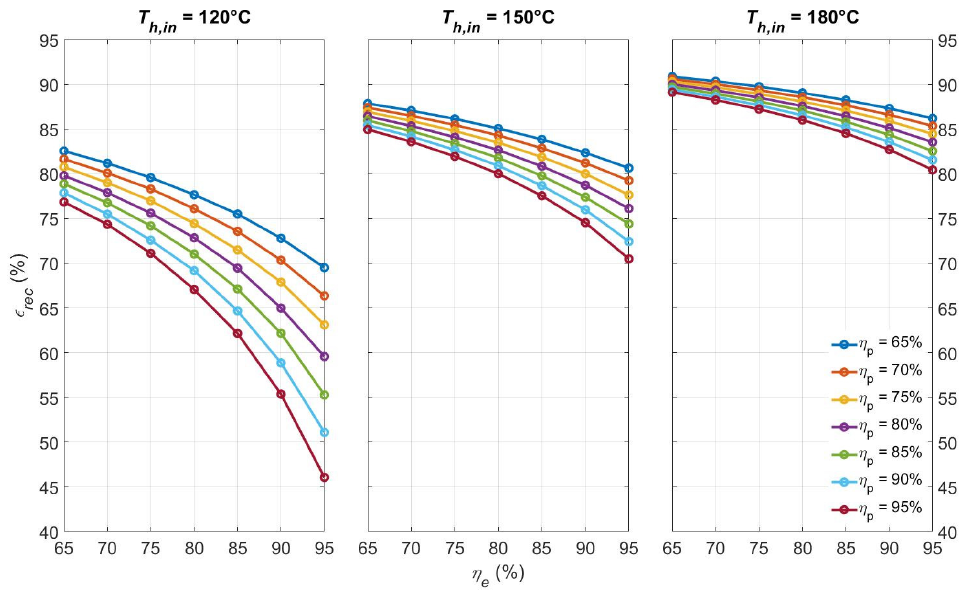
Figure 14. 𝜀 (cid:3045)(cid:3032)(cid:3030) at the design point under different circumstance of 𝜂 (cid:3043) , 𝜂 (cid:3032) , and 𝑇 (cid:3035),(cid:3036)(cid:3041) . Figure 14. ε rec at the design point under different circumstance of η p , η e , and T h , in